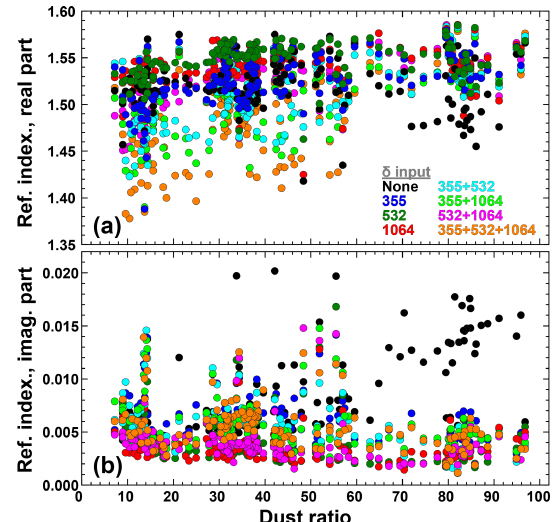
Figure 9. The retrieved (a) real and (b) imaginary parts of the re- fractive index and their connection to the dust ratio for the different input data